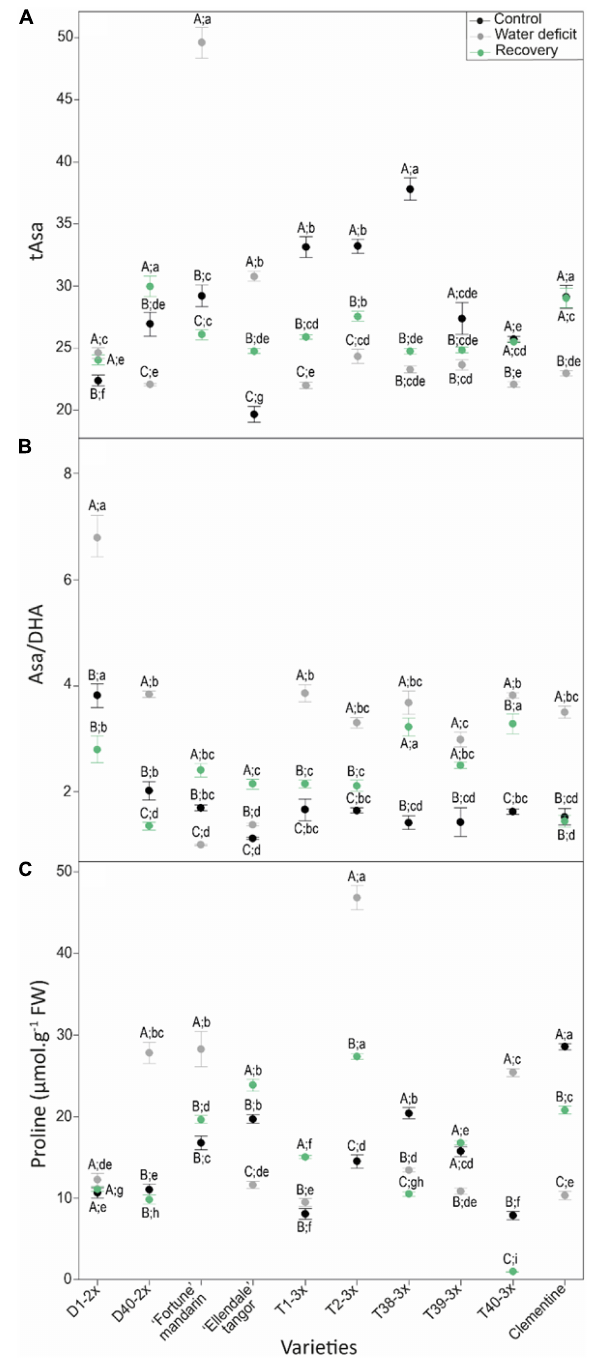
FIGURE 5 | Evolution of (A) total ascorbate (tAsa), (B) redox status (Asa/DHA), and (C) proline contents in leaves of varieties under three different water conditions: control (black points), water deficit (gray points), and after rehydration (recovery; green points). All data are mean values ( ± S.E.) of three independent measurements ( n = 3). Data were analyzed using ANOVA and Fisher LSD test ( P < 0.05). Different capital letters indicate significant changes between the conditions (control, water deficit, and recovery) for each variety while different lower case letters indicate changes between the varieties for each